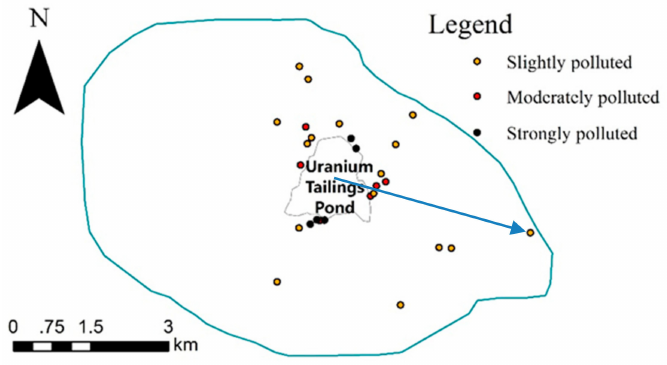
Figure 2. The distribution of the 27 samples whose U’s CF 2 > 1.